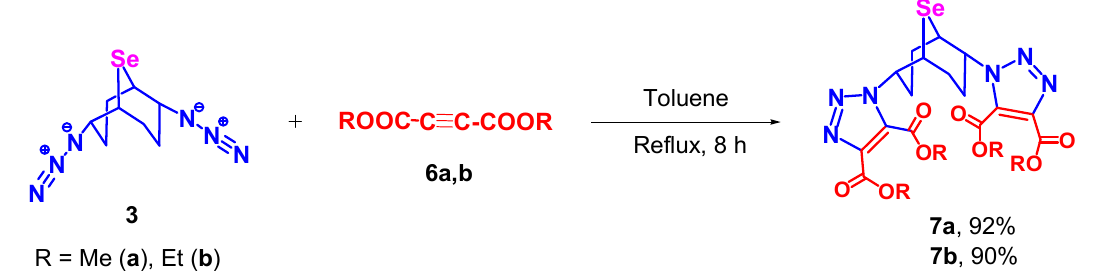
Scheme 7. Synthesis of compound 7a , b by the 1,3-dipolar cycloaddition reaction of diazido derivative 3 with dimethyl and diethyl acetylenedicarboxilates 6a , b .